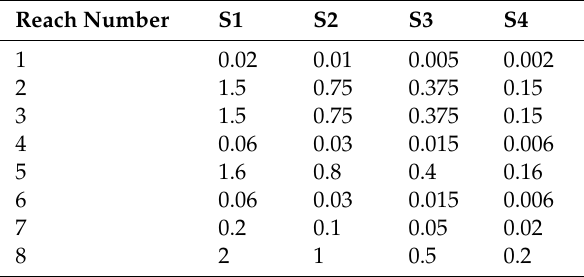
Table2. Theminimumflow, Qmin(m 3 / s), inthereachfordi ff erentscenariosofirrigationwaterdiversion.